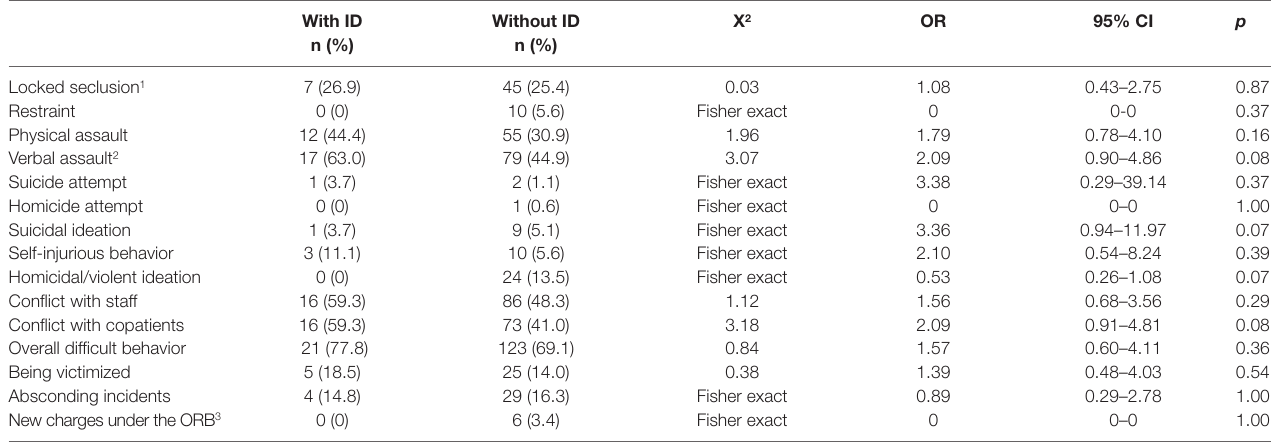
TABLE 4 | Past-year behavioral incidents of inpatients with and without intellectual